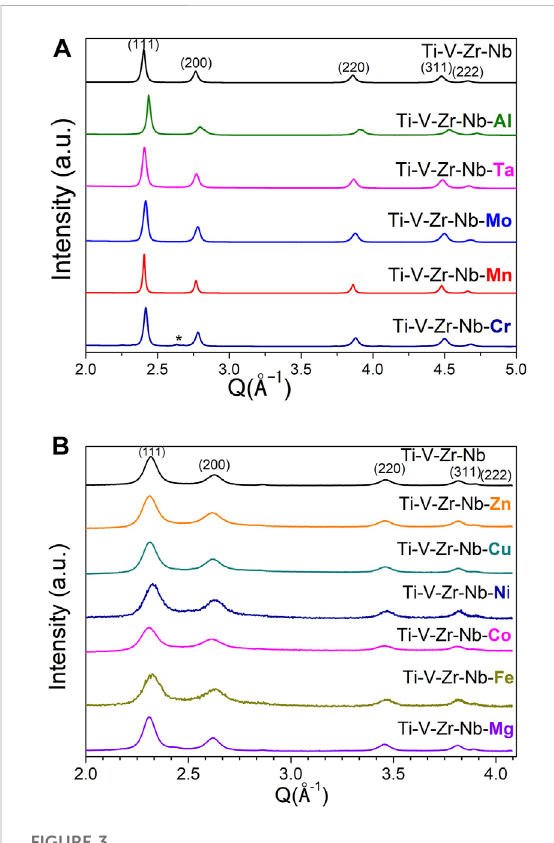
FIGURE 3 SR-XRDpatternsofthehydridesofcompositionspreparedby arc melting (A) and laboratory XRD of the hydrides prepared by reactiveballmilling (B) .Forthesakeofcomparison,thequaternary hydrides prepared by hydrogenation of AM alloy and by RBM are also shown.